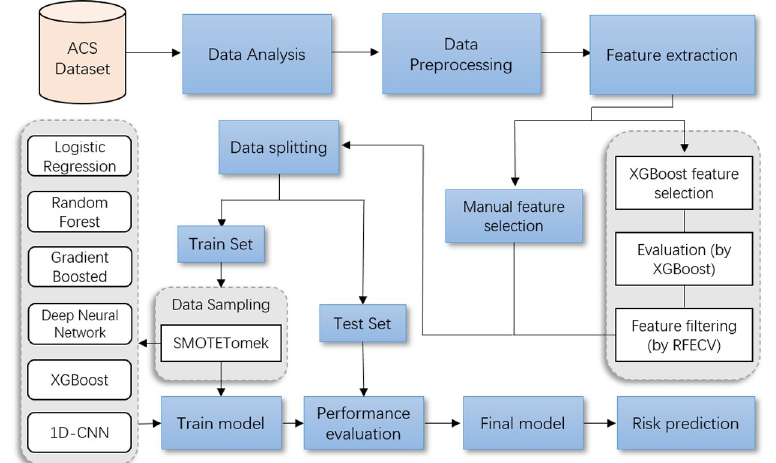
Fig 1. Model development and evaluation pipeline. Process flowchart for visual data processing and model